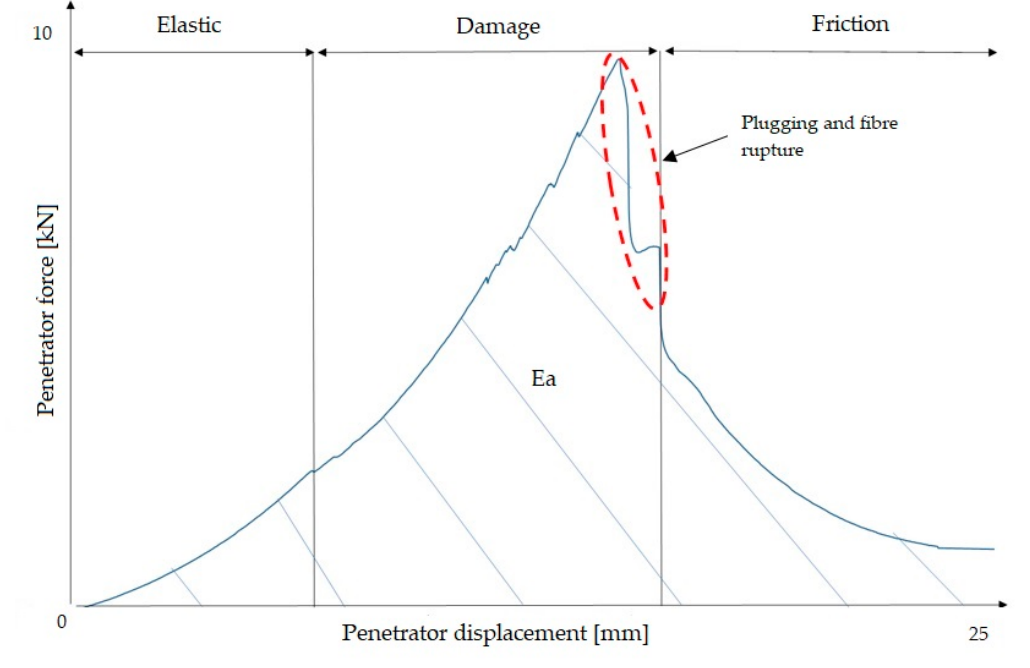
Figure 5. Diagram of laminate damage as a result of a quasi-static puncture test.